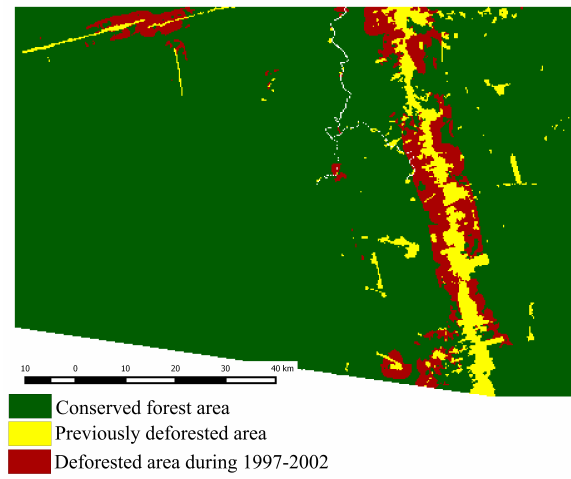
Figure 3: LUCC map (1997-2002). Previously deforested area refers to forest area cleared before 1997. Some deforestation patches are located in remote areas